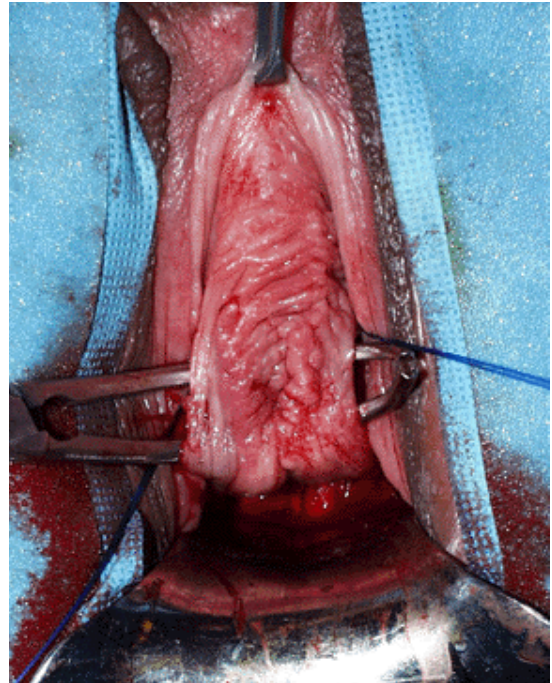
FIGURE 3 . The incision made as the anchor pierces the vaginal epithelium is widened with a right angle clamp. A subepithelial tunnel is created at the level of the bladder neck towards the contralateral side. Small pockets are created towards the pubic bone such that the excess sling material can reside easily.